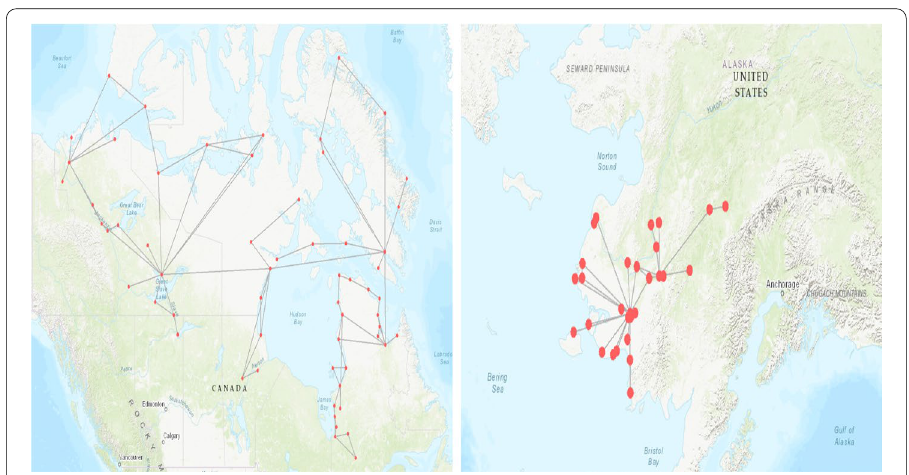
Fig. 11 Typical small local components structures. The left image presents an example of string-based topology. It is the largest small local component in Canada. The right image gives an example of star-based topology. It is the second largest small local component in